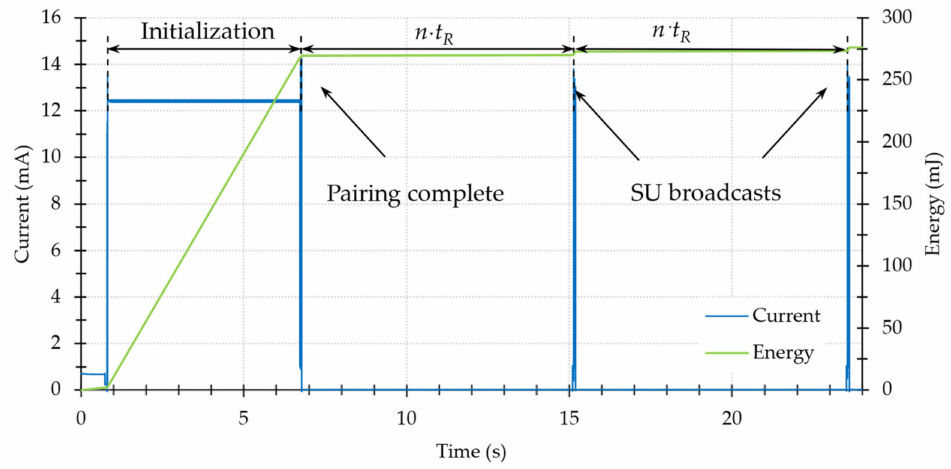
Figure 11. Typical instantaneous supply current and energy transfer to the SU prior to and during the initial connection with the BMC and the sequential reporting.